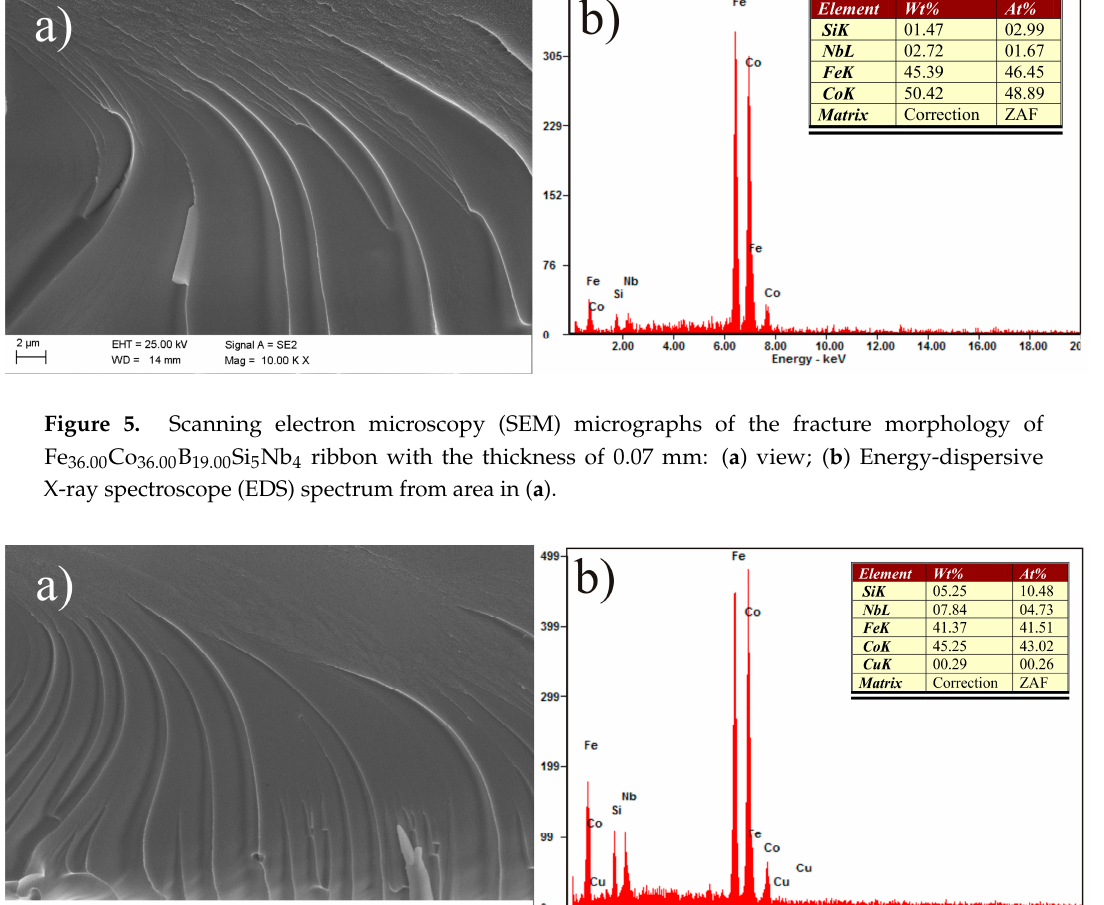
Figure 4. High-resolution transmission electron microscopy (HTREM) images and the selected area electron diffraction (SAED) of ( a ) Fe 36.00 Co 36.00 B 19.00 Si 5 Nb 4 and ( b ) Fe 35.75 Co 35.75 B 18.90 Si 5 Nb 4 Cu 0.6 amorphous alloys in rod form with the diameter of 1.5 mm.